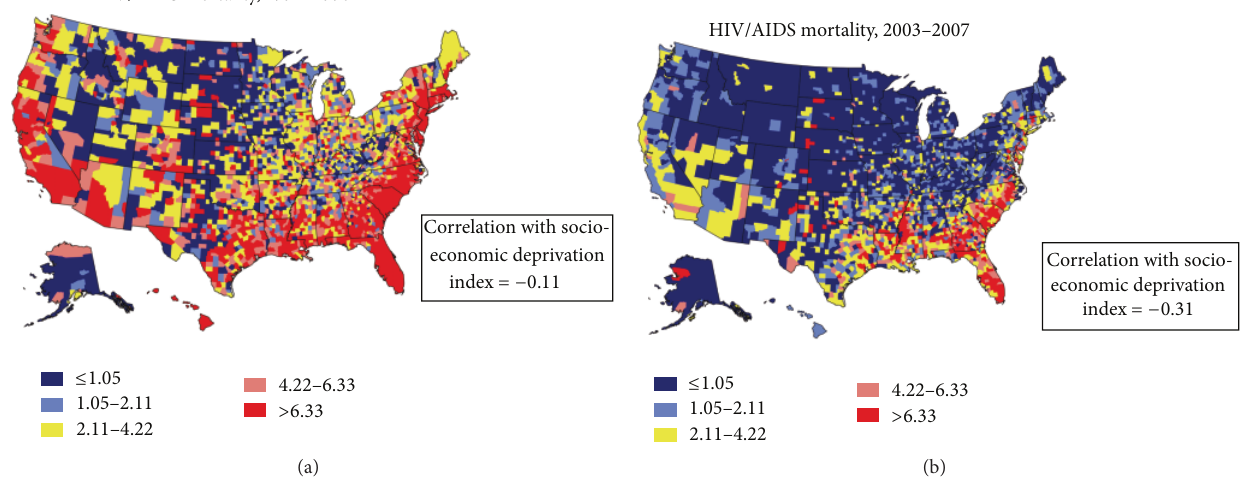
Figure 7: Age-adjusted HIV/AIDS mortality rates per 100,000 population, 1992–2007 (2000 US population used as standard; 3,141